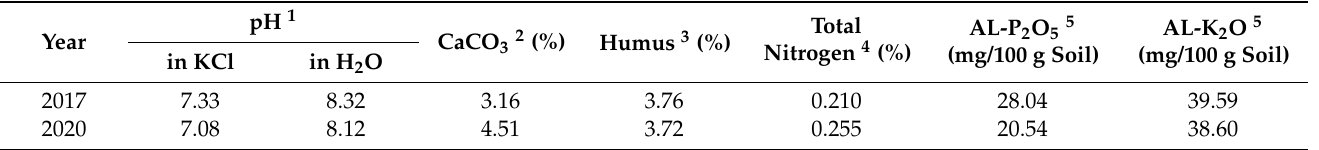
Table 1. Basic chemical characteristics of the